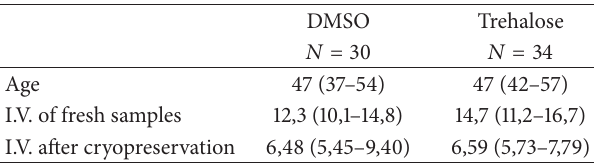
Table 1: Viability index with different cryoprotectants. Viability indexes (I.V.) was similar between the two